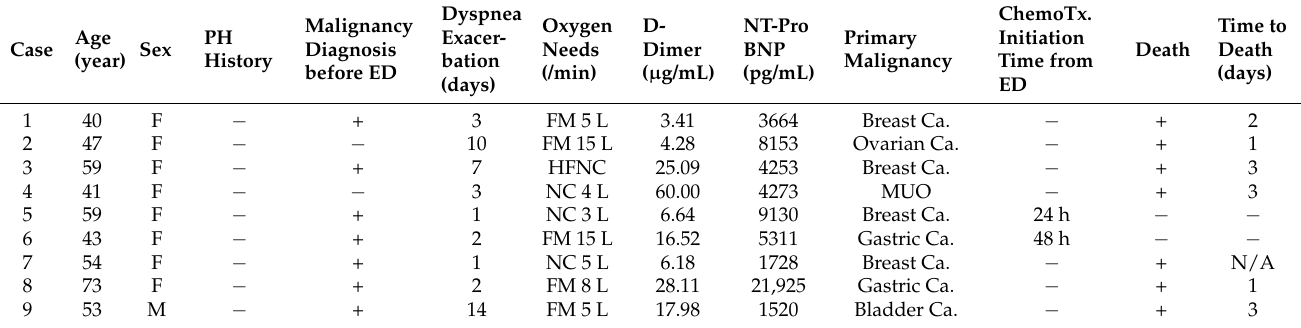
Table 1. Demographic characteristics and clinical findings concerning patients with PTTM in the